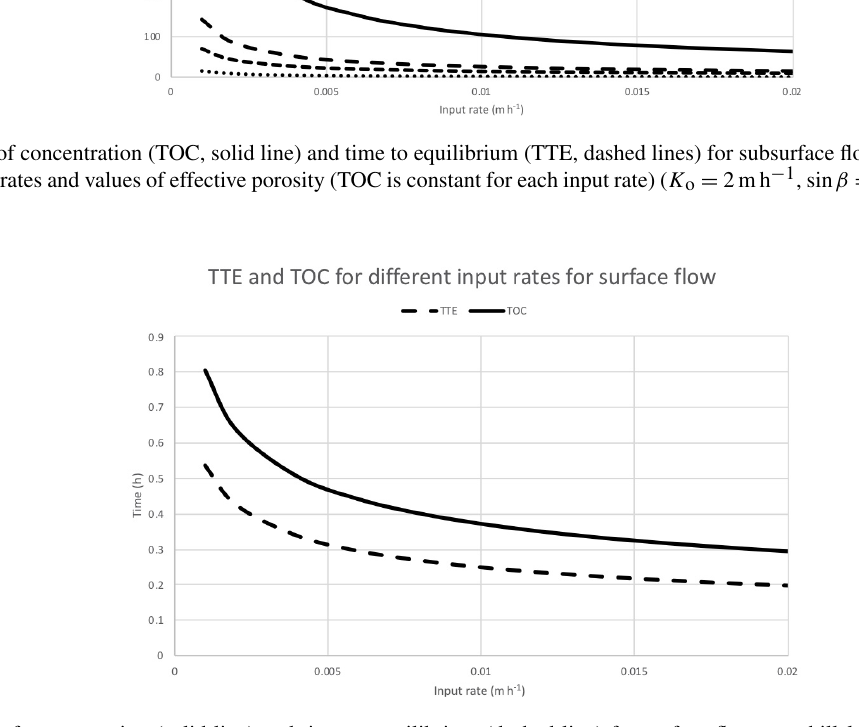
Figure A2. Time of concentration (solid line) and time to equilibrium (dashed line) for surface flow on a hillslope of 100m for different values of the input rate ( C = 10m 0 . 5 s − 1 , sin β = 0 . 05) (Eqs. A15 and A16).